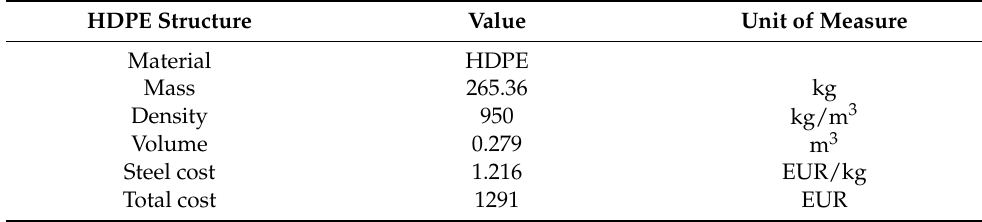
Table 7. HDPE float cost estimation.